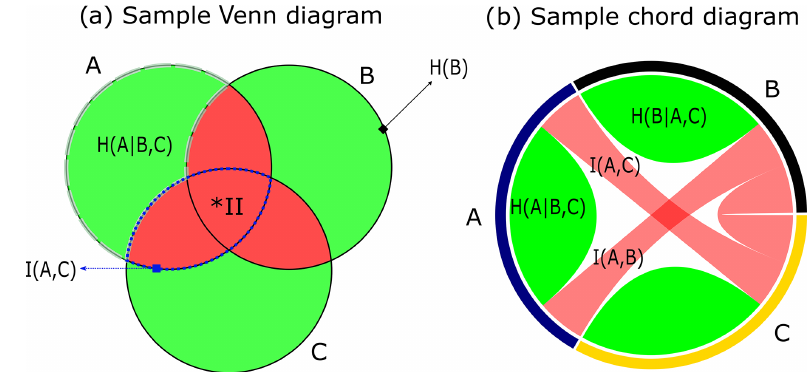
Figure 2. Template illustrations of information interactions with (a) a Venn diagram and (b) a chord diagram. The green and red areas in both diagrams show a graphical representation of conditional entropy and mutual information respectively. The solid line circles in the Venn diagram depict single-variable entropy. *II is information interaction between three variables. The sector size in the outer circle in the chord diagram is composed of arcs whose relative lengths correspond to the sum of pairwise information interactions and conditional entropy of each variable and are best not